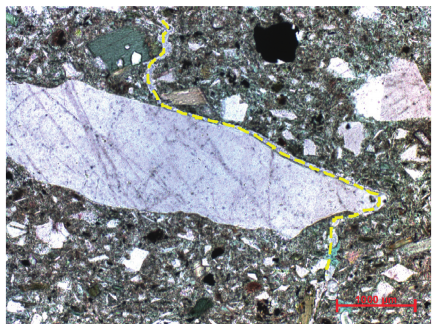
Figure 11: “C-10-2- middle” backfill casting thin section image.